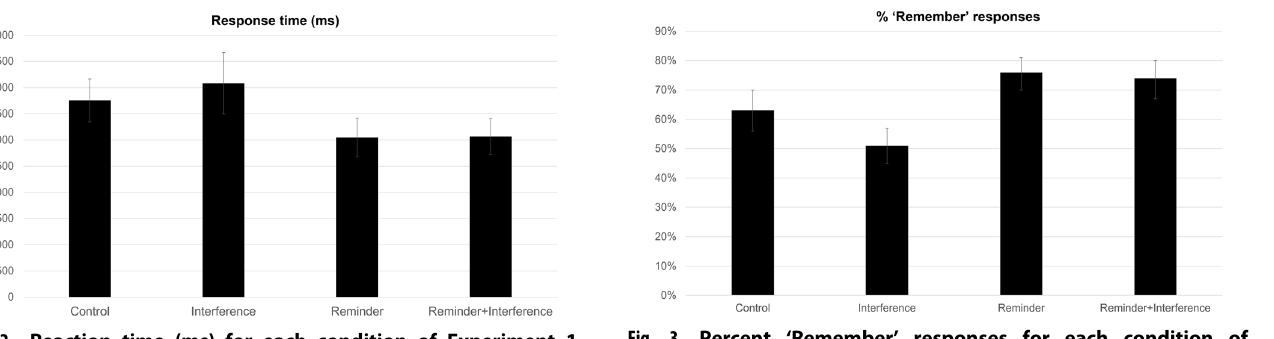
Fig. 2 Reaction time (ms) for each condition of Experiment 1. Brackets represent 95% con fi dence intervals.